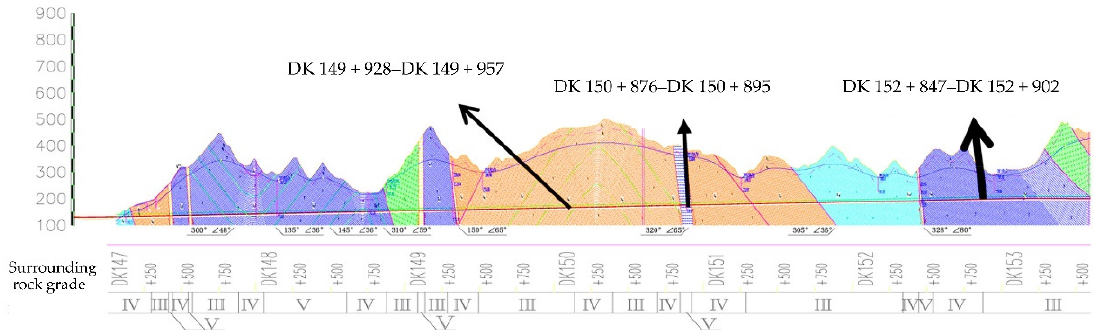
Figure 1. Geological longitudinal section of Zigaojian tunnel (unit: m).